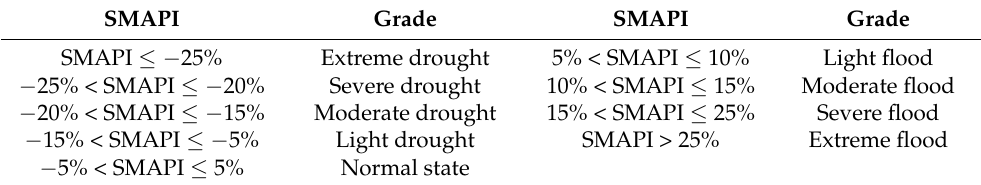
Table 2. Drought and flood grades of